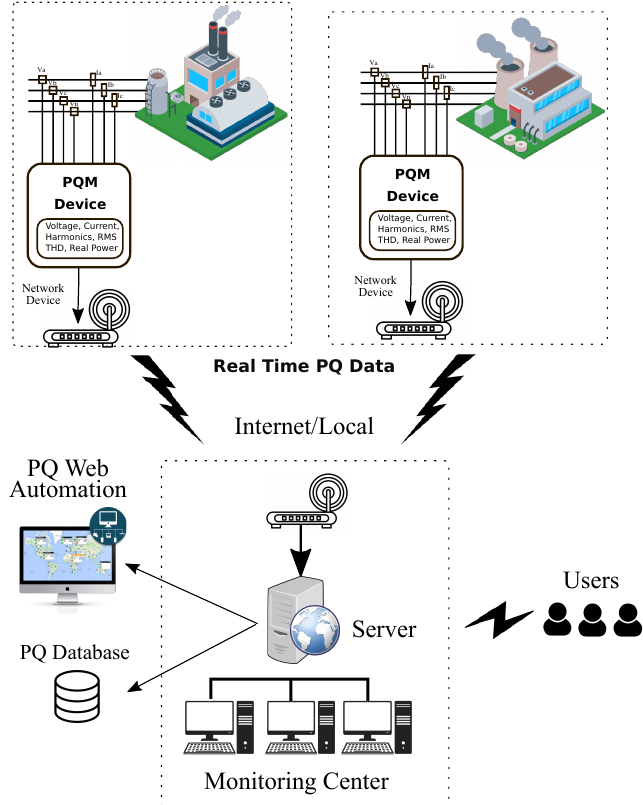
Figure 4. General Architecture of a Power Quality Monitors (PQM) system (adapted from Reference